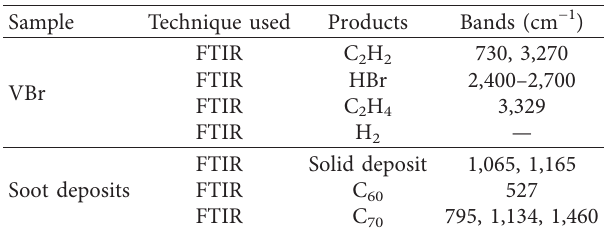
Figure 1: Experimental arrangements employed for the IRMPD of the VBr samples for inducing black soot. Table 1: Identification of products obtained from IRMPD of